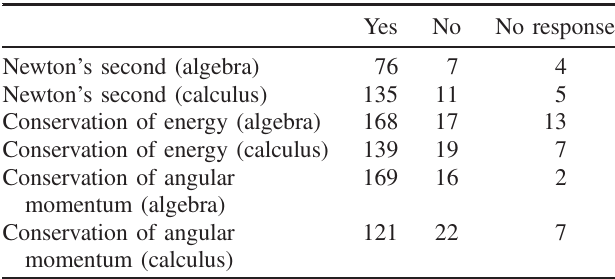
TABLE II. Student responses to the question “ Was the tutorial effective at clarifying any issues you had with the problem covered in the tutorial? ” in large enrollment classes as a self-study